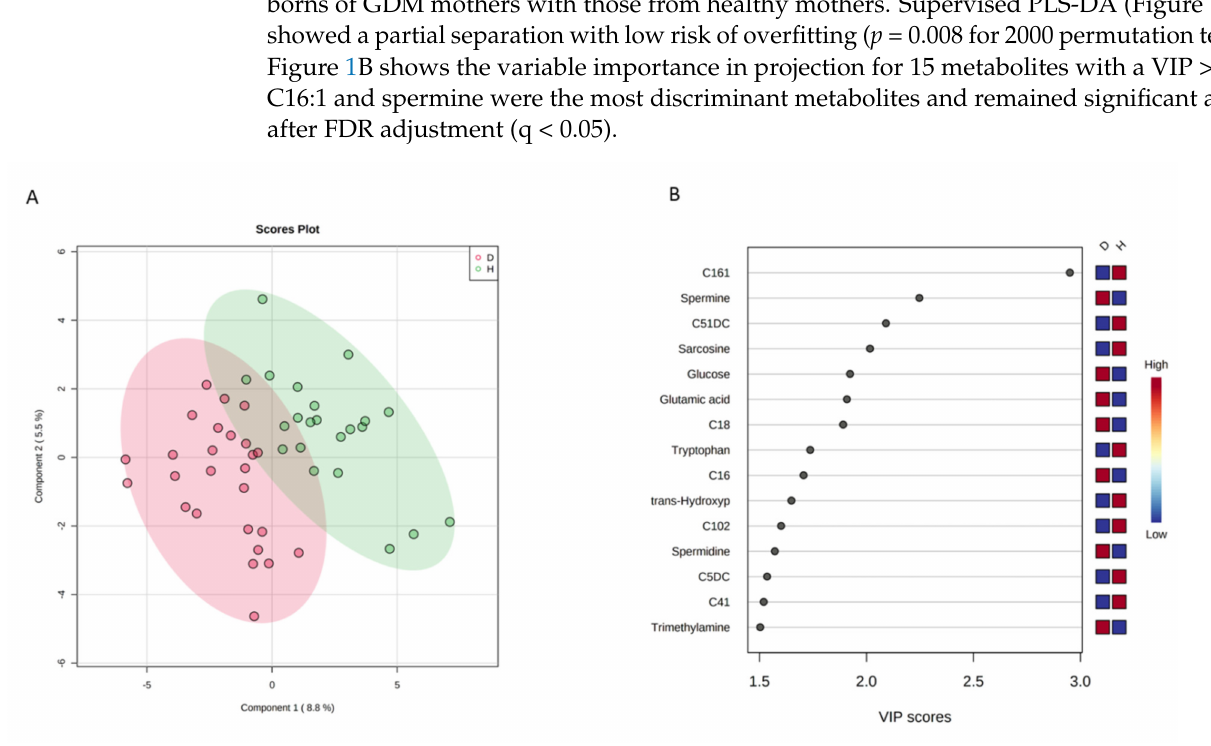
Figure 1. Multivariate analysis showing the comparison between urine metabolite data acquired for newborns of GDM (D) and healthy mothers (H). ( A ) Partial least squares discriminant analysis (2-D PLS-DA) score plots; ( B ) Variable importance in projection plot. The most discriminating metabolites are shown in descending order of their coefficient